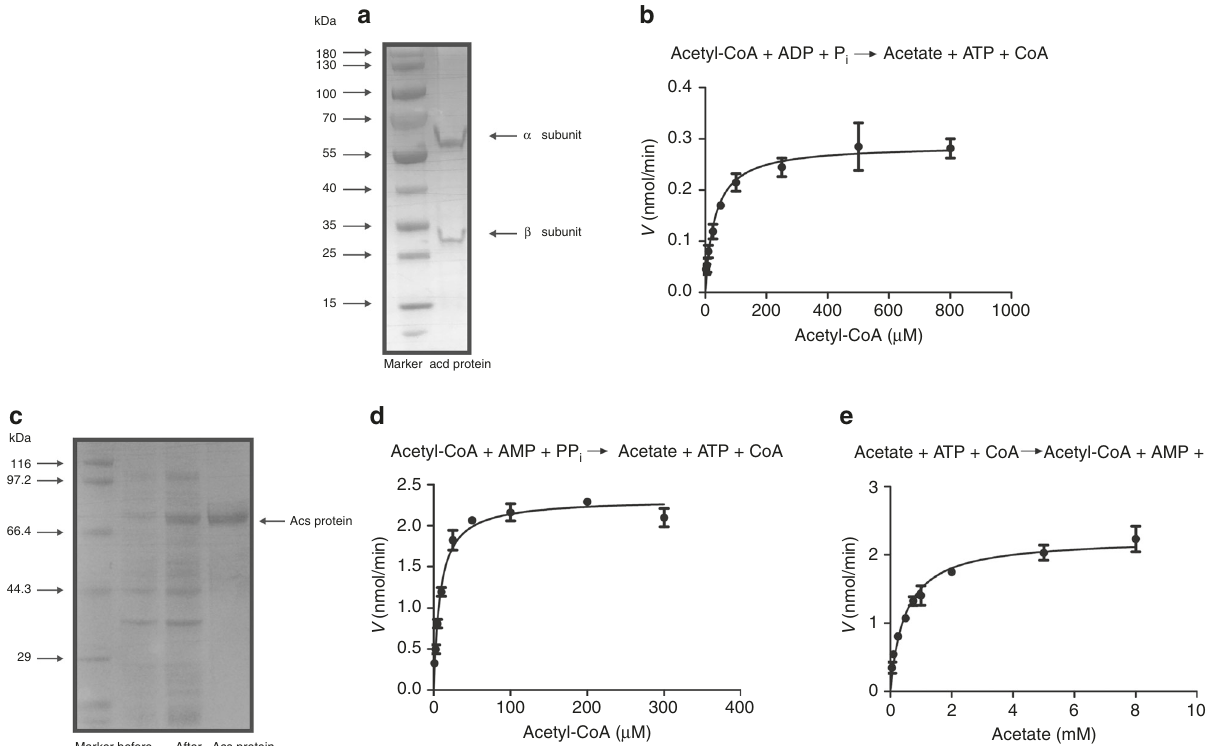
Fig. 4 Enzyme puri fi cation and activity assay. Puri fi ed ADP-forming acetate-CoA ligase ( a ) and acetyl-CoA synthetase ( c ) from ANME-2a as analyzed by SDS-PAGE as well as their activity assay ( b , d , e ). The catalytic activity is shown as mean value with standard deviation ( n =